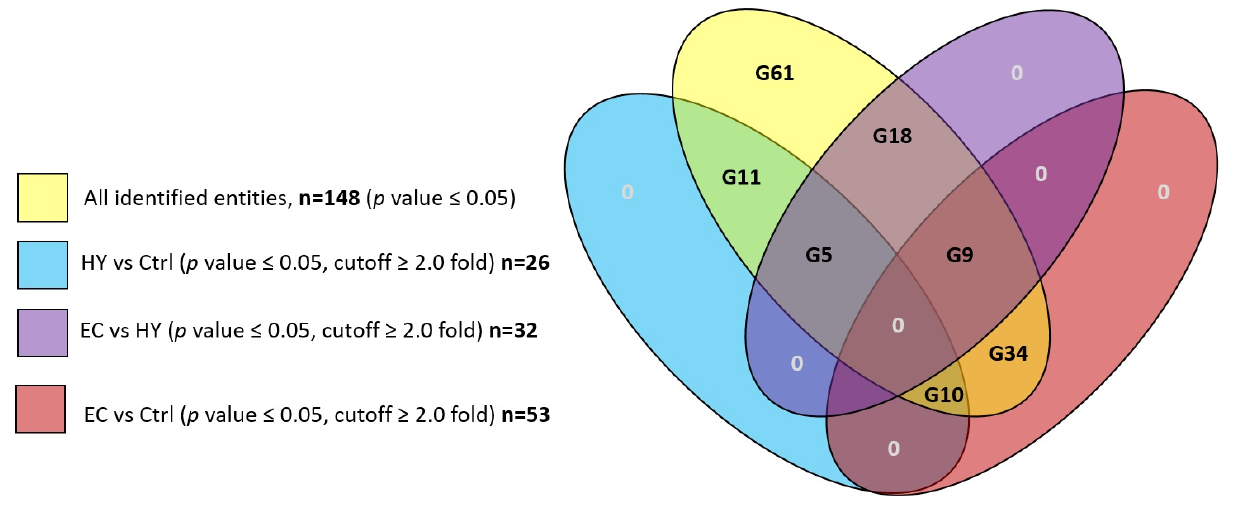
Figure 3. Venn diagram showing overlap among the groups HY vs. Ctrl, EC vs. HY, EC vs. Ctrl with overall detected proteins.